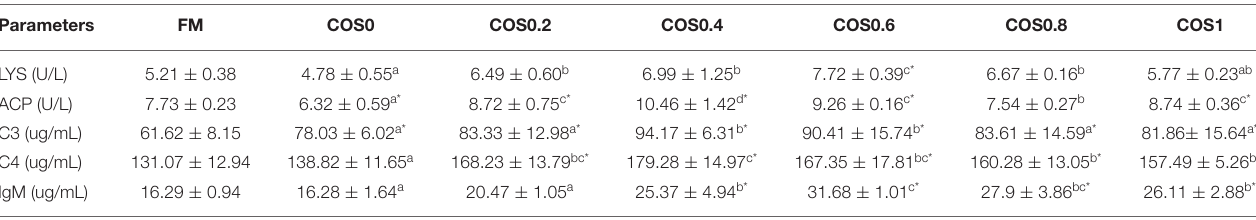
TABLE 6 | Intestinal non-specific immunity indices of hybrid grouper fed with experimental diets for 8 weeks. Parameters